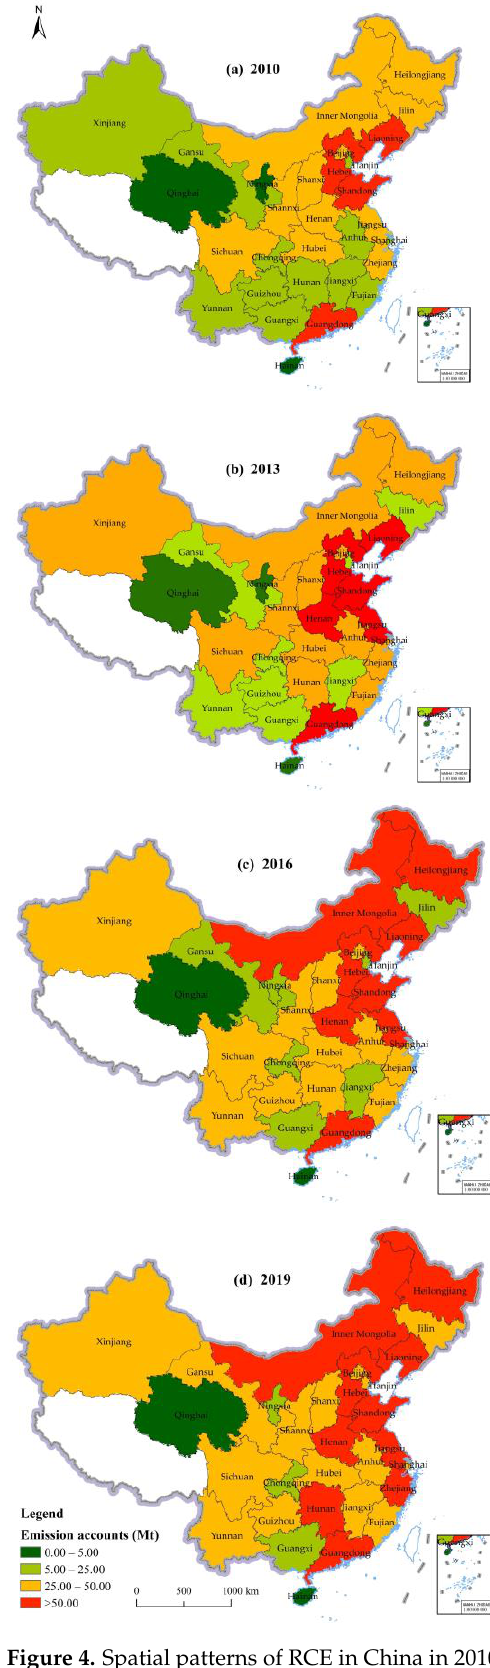
Figure 4. Spatial patterns of RCE in China in 2010 ( a ), 2013 ( b ), 2016 ( c ), and 2019 ( d ) (unit: M t ). From a national perspective, both urban and rural RCEs have increased. Urban RCE increased from 554.71 Mt in 2010 to 867.41 Mt in 2019. Rural RCE increased from 302.49 Mt in 2010 to 474.63 Mt in 2019. The urban sector was the main contributor to RCE, ac- counting for approximately 64% of total RCE during the study period. Regionally, urban RCE formed the main component of the three major regions. However, the changes in the proportions of CO 2 emissions from the urban and rural sectors in different regions had their own characteristics during the study period. The proportion of RCE of total CO 2 emissions in the eastern region was basically stable at 65%. The proportion of urban RCE in the central region decreased the most, from 65.15% in 2010 to 62.93% in 2019. The in- crease in the proportion of rural RCE in the western region was greatest, from 62.49% in 2010 to 66.14% in 2019. Per capita RCE is used to describe the differences between urban and rural regions. The per capita RCE of urban residents was higher than those of rural residents during the study period at the national level but the gap between urban and rural areas was con- stantly shrinking. Objectively, the overall living standards of urban residents are higher than those of rural residents. As a consequence of new rural construction and rural revi- talization in China, the development of rural areas has been accelerating, the living stand- ards of residents have been continuously increasing, and the gap between urban and rural development levels has been shrinking. Hence, the differences between urban and rural RCEs have been shrinking. It is worth noting that obvious regional differences exist in per capita RCE between urban and rural areas. The rural RCE of the eastern region has been higher than that of urban areas since 2014. Urban RCEs in the central and western regions were significantly greater than those of rural areas. Rural RCE in the central region grew rapidly, narrowing the gap with urban RCE. Although rural RCEs in the western areas increased during the study period, they were still quite a bit lower than those of urban